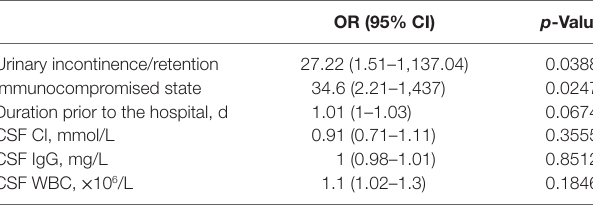
Table 5 | Poor outcome factors in onconeural antibody associated disorders patients: multivariate analysis.